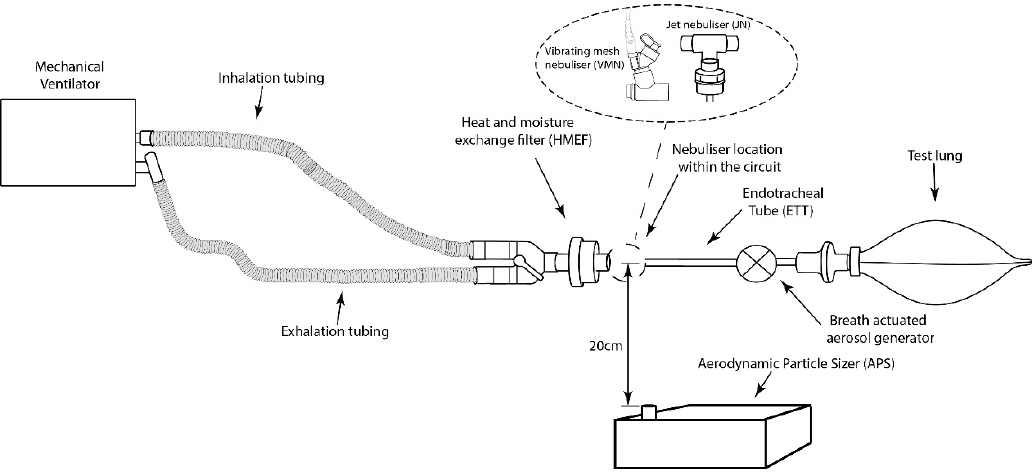
Figure 1. Illustration of experimental setup.